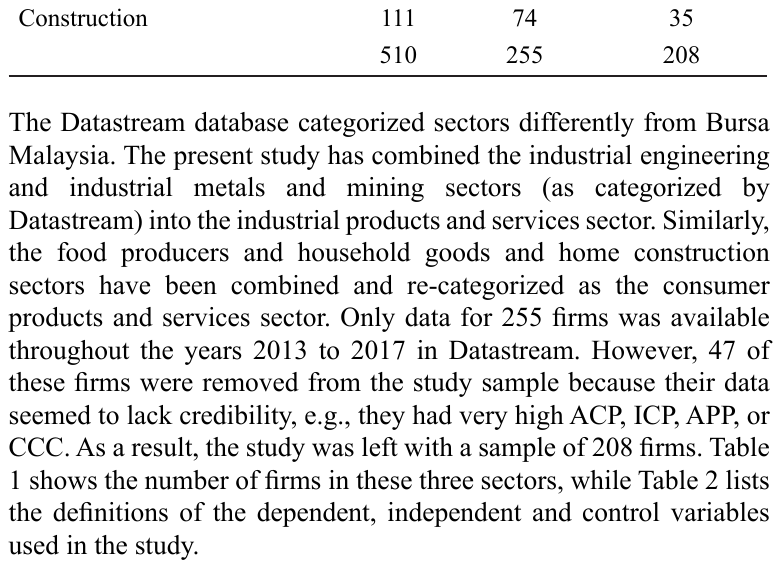
Frequency of Firms by Sector Sectors Number Industrial products & services